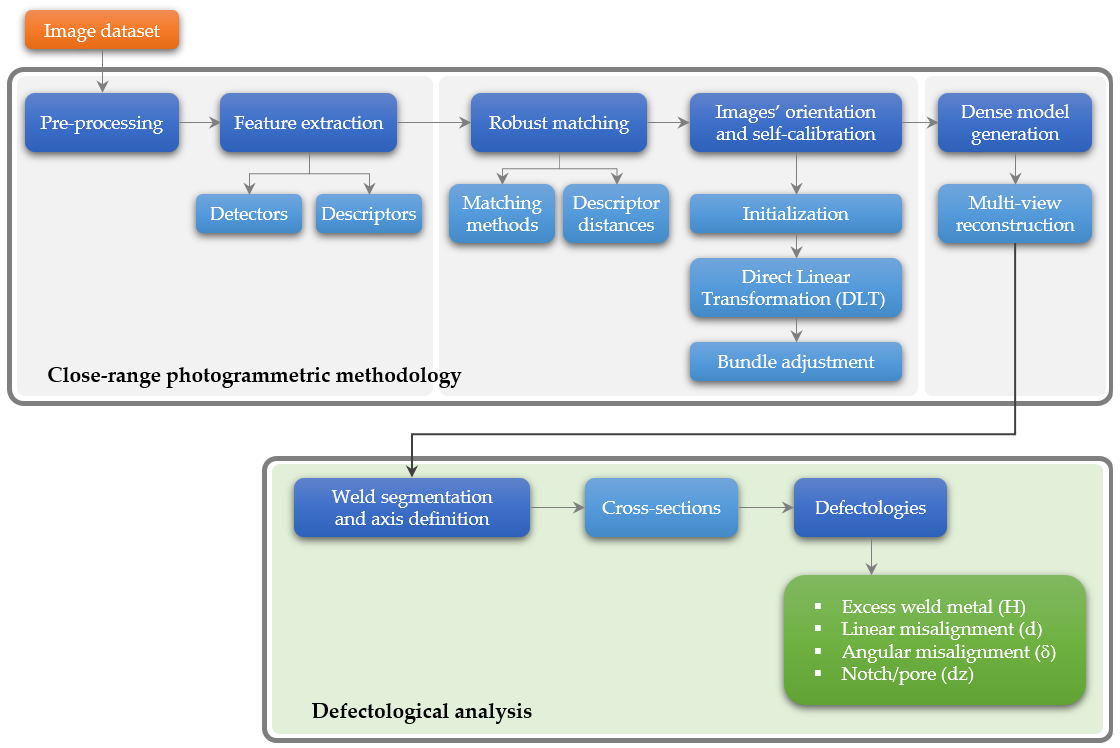
Figure 1. WELDMAP: structure and modules organisation.